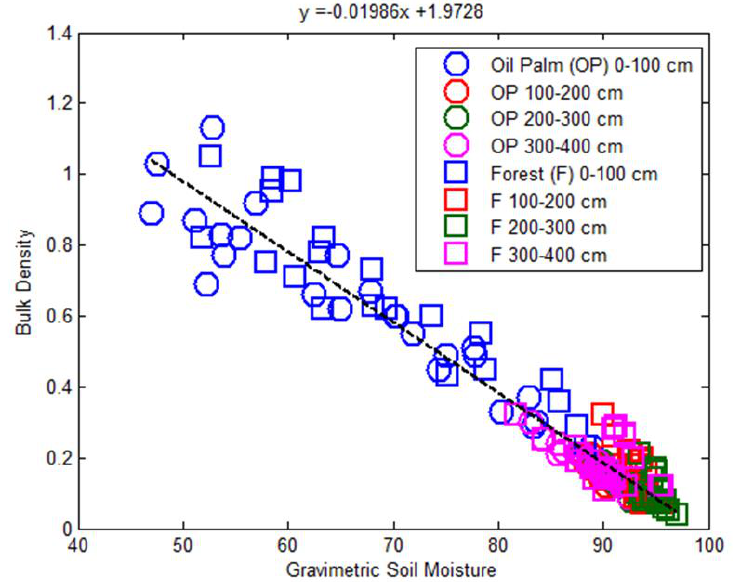
Figure 11. Inverse relationship between bulk density and gravimetric soil moisture based on the data of Sim et al.